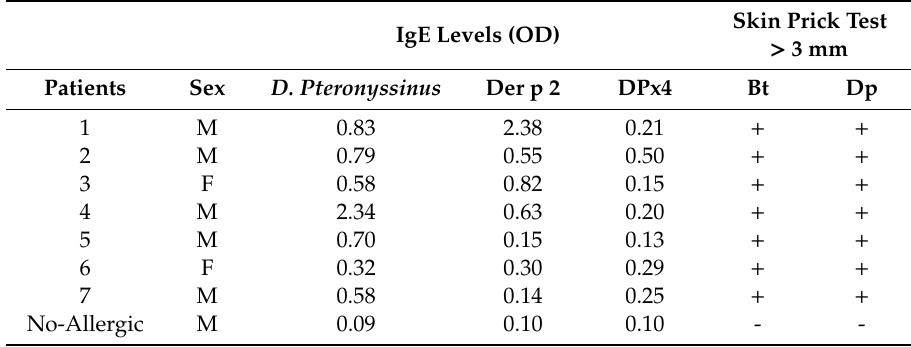
Table 3. Immunological characteristics of sera used in basophil